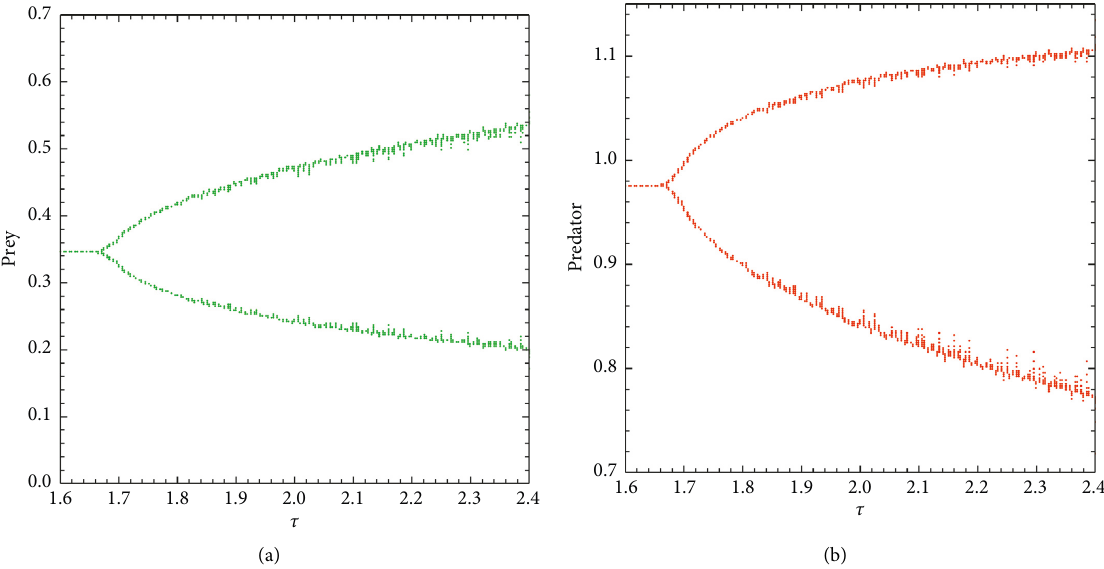
Figure 10: The bifurcation diagram of the model (52) with m